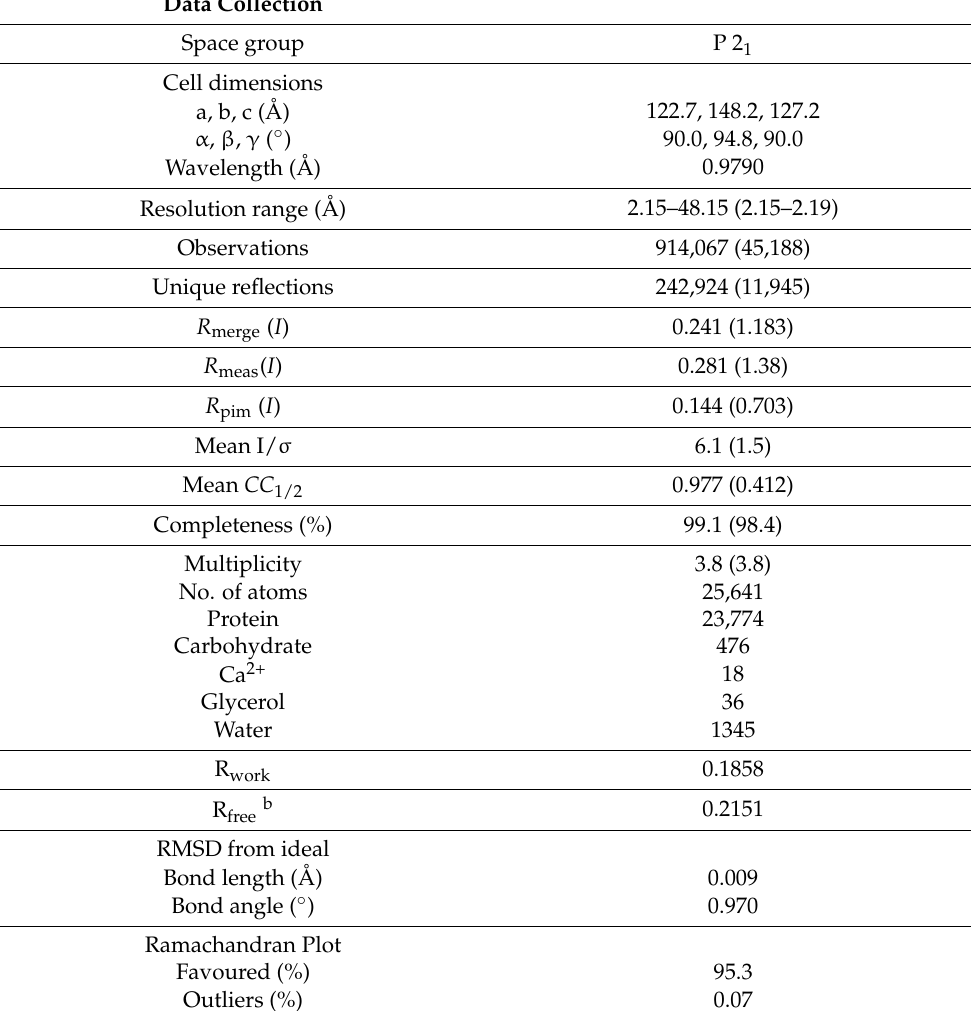
Table 1. Data collection and refinement statistics a